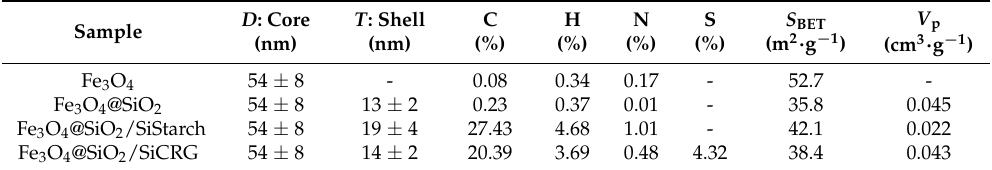
Table 1. Physicochemical properties of magnetic nanohybrids and magnetic particles without biopolymer ( D = diameter; T = thickness; S BET = Specific surface area; V p = Pore volume).